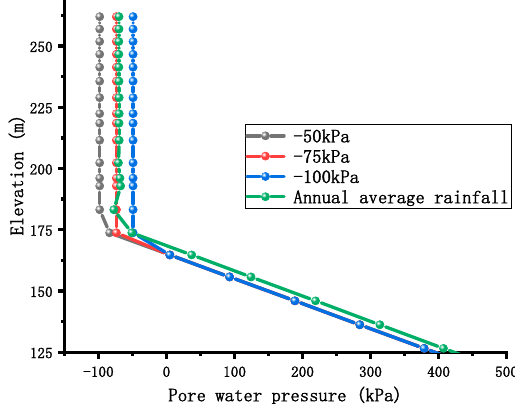
Figure 4. Daily rainfall from 1 March to 2 August 2019 (155 days in total).